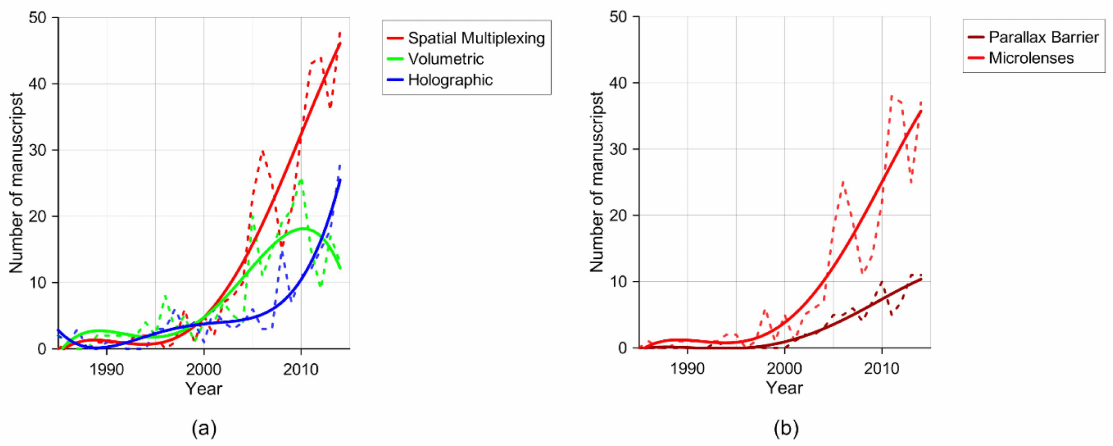
Figure 5. Number of manuscripts as a result of the search in Scopus database (Elsevier). The search was restricted to only the titles of the manuscripts: ( a ) Autostereoscopic technologies and ( b ) Spatial multiplexing technologies. Queries for each technology were “holographic and display and 3D (or three-dimensional or autostereoscopic)”, and “volumetric display” and for spatial multiplexing, “parallax barrier display” and “lenticular (or lenses or microlenses) and display”. Dashed lines are real data, while solid lines are tendency lines (polynomial fit). The fitting is done by an orthogonal polynomial with four